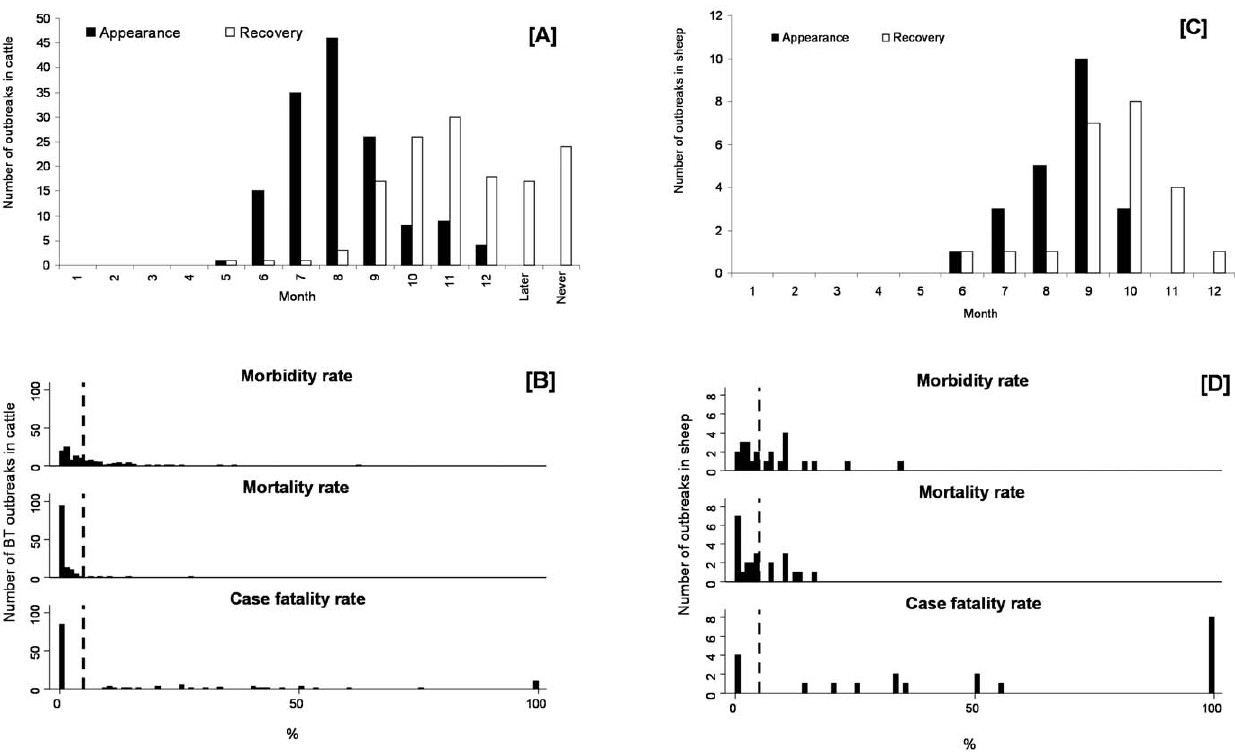
Figure 4. Starting month of clinical appearance and recovery ([A], [C]), and morbidity, mortality and case fatality rates ([B], [D]) for cattle and sheep outbreaks in southern Belgium (random surveys). [A] and [B]: 144 cattle outbreaks confirmed by RTqPCR and/or competitive ELISA; [C] and [D]: 23 sheep outbreaks confirmed by RTqPCR and/or competitive ELISA; Later: if recovery was observed after December 2006; Never: if recovery was not observed before the end of your study (maybe those cows are recovered by now); For [A] and [C], only 2 cattle breeders and 1 sheep breeder observed BT clinical appearance before May 2006 and June 2006, respectively but there is not further information regarding the precise time point so these observations are not cited in the figure; For [B] and [D], the vertical dotted line corresponds to a rate of